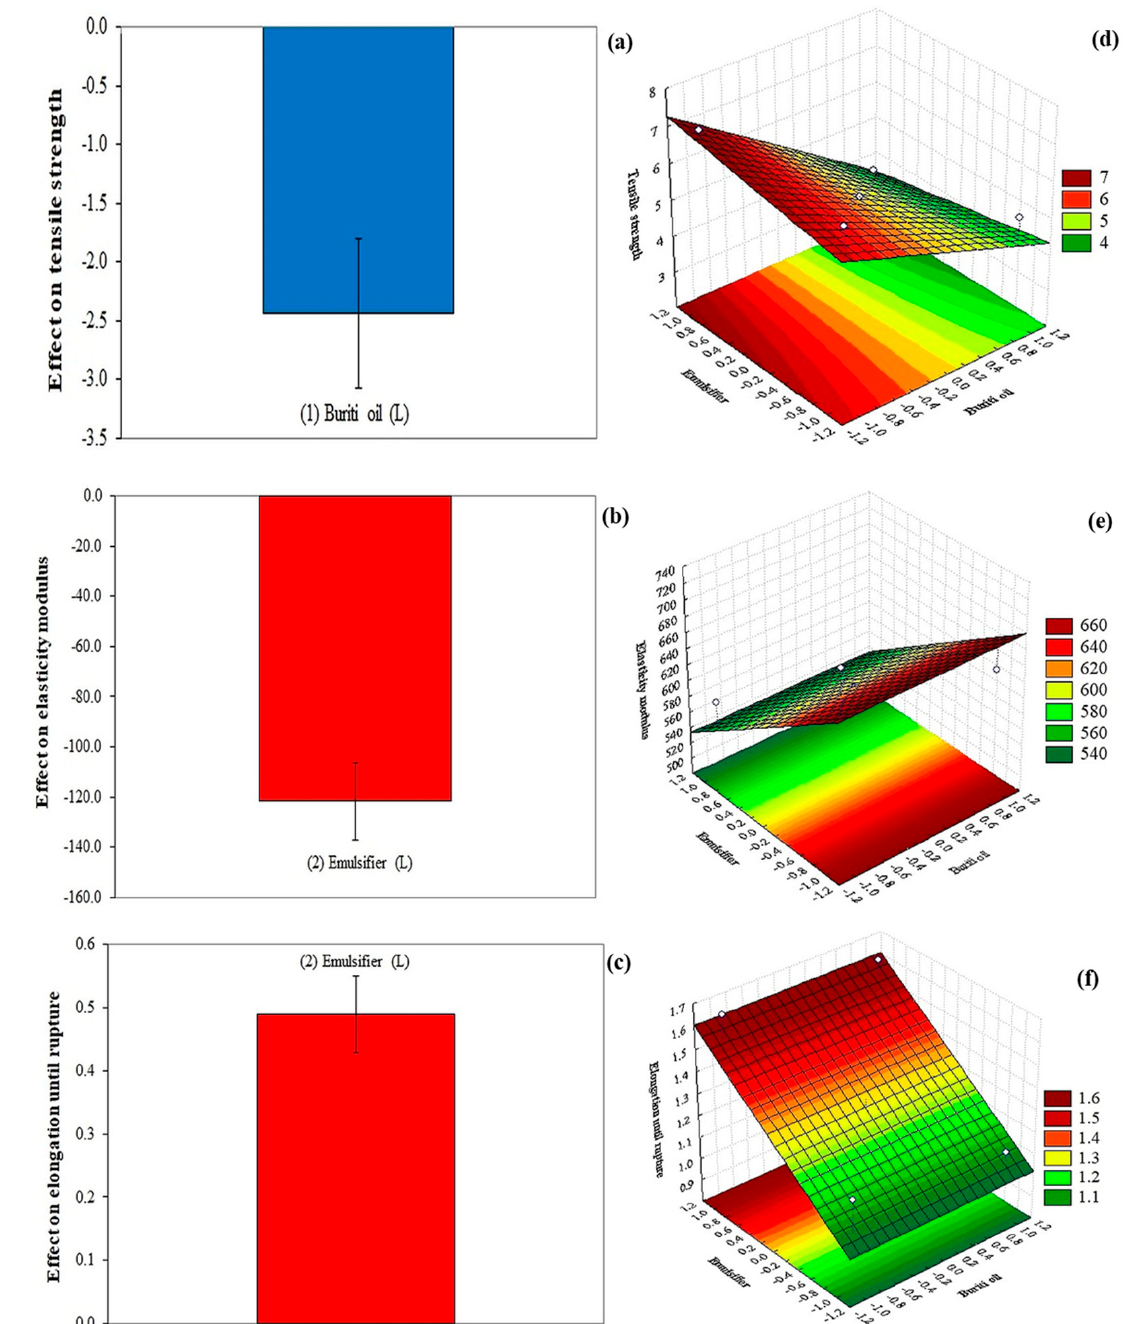
Figure 2. Effect of buriti oil and emulsifier (Tween 20) on the tensile strength ( a ), elasticity modulus ( b ), and elongation until rupture ( c ) of the cassava-starch-based films. Response surfaces show the influence of buriti oil and emulsifier on the tensile strength ( d ), elasticity modulus ( e ), and elongation to rupture ( f ) of the films.